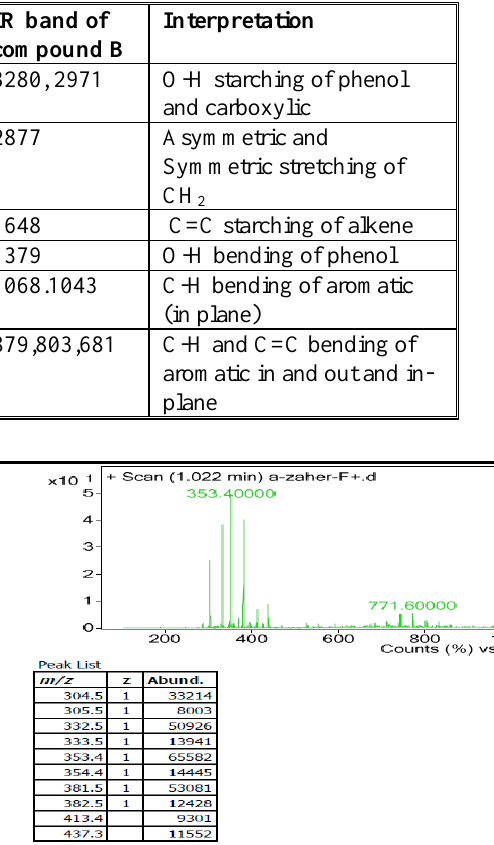
Figure 12. Lc mass diagram for compound C.